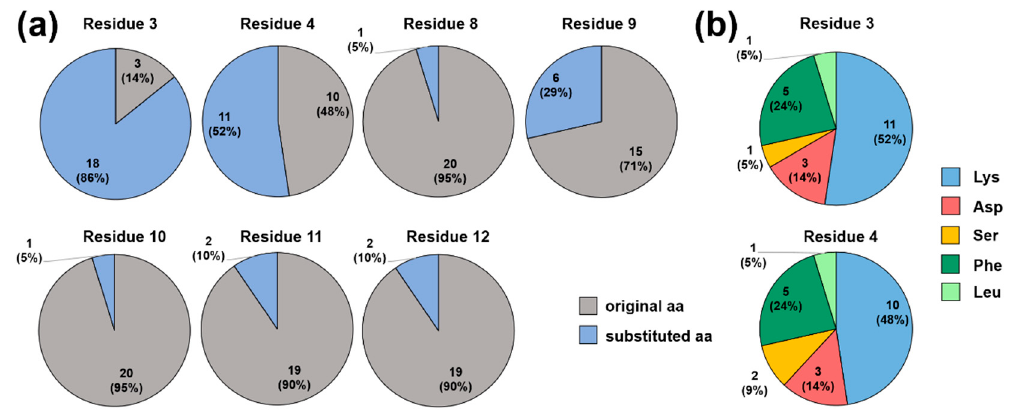
Figure 4. Pie diagrams indicating the substituted residues (blue) of the 21 best competing ARV-1502 analogs (relative FP < 80%; unlabeled peptide concentration of 1.2 µmol/L) for each residue ( a ) and most favorable substitutions in positions 3 and 4 ( b ).